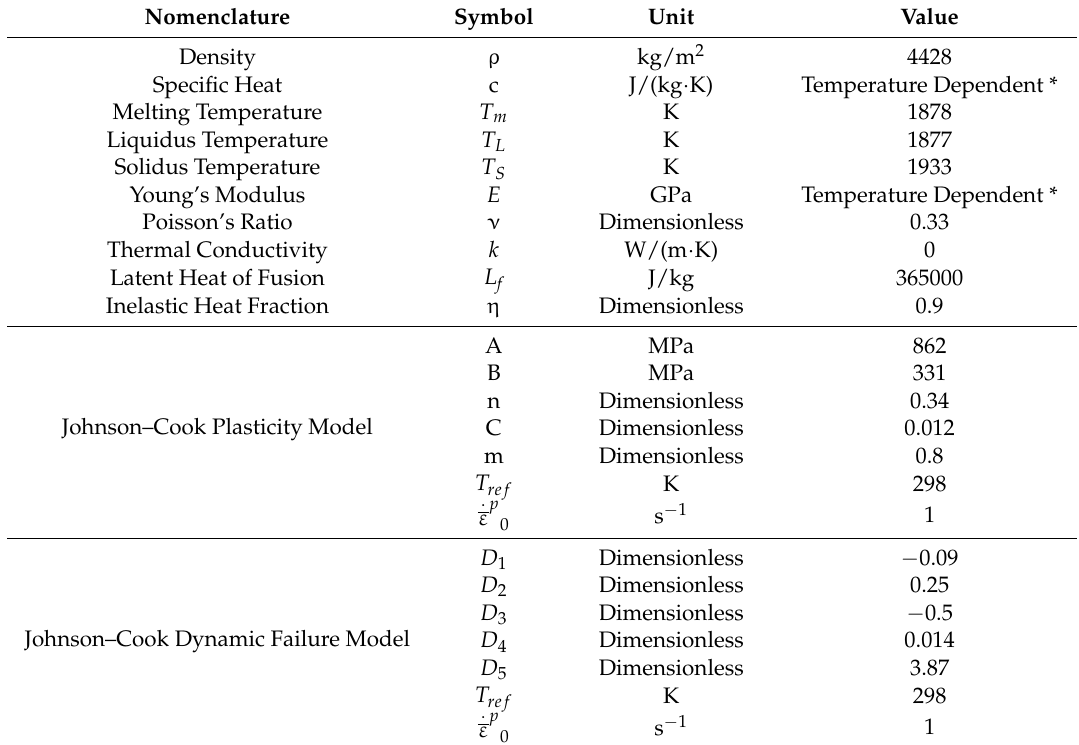
Table 3. Material properties of the Ti64 alloy used for